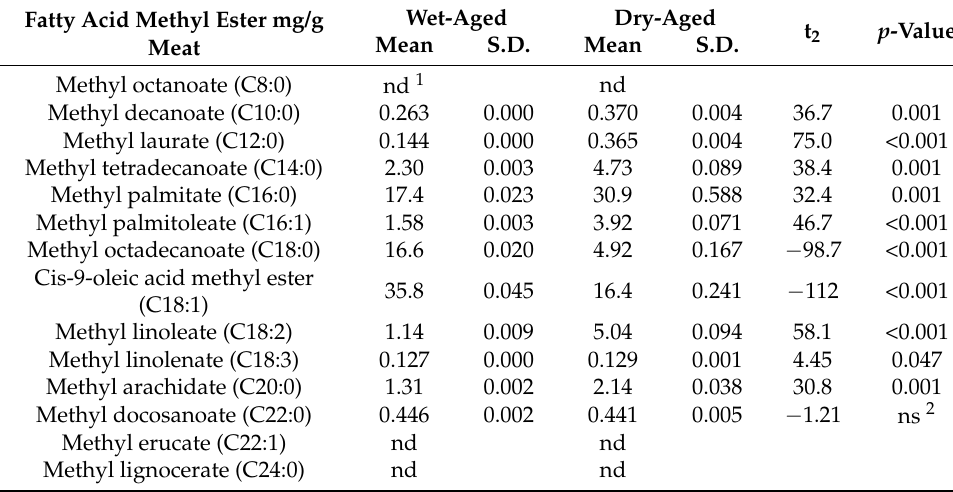
Table 5. Effect of ageing method (dry vs. wet) on fatty acid methyl ester concentration (mg/g) in raw mutton patties, standard deviation (s.d.), t-value (t) with subscript degrees of freedom and statistical significance ( p